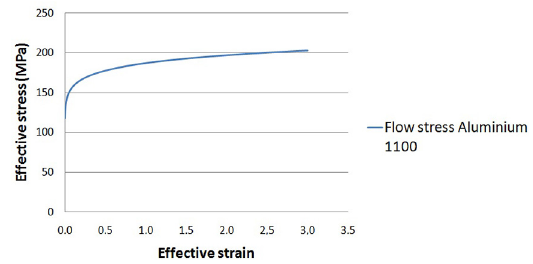
Figure 8. Effective strain rate - thickness of 3.0 mm, velocity of 104.72 mm/s and reduction of 16.67% (simulation